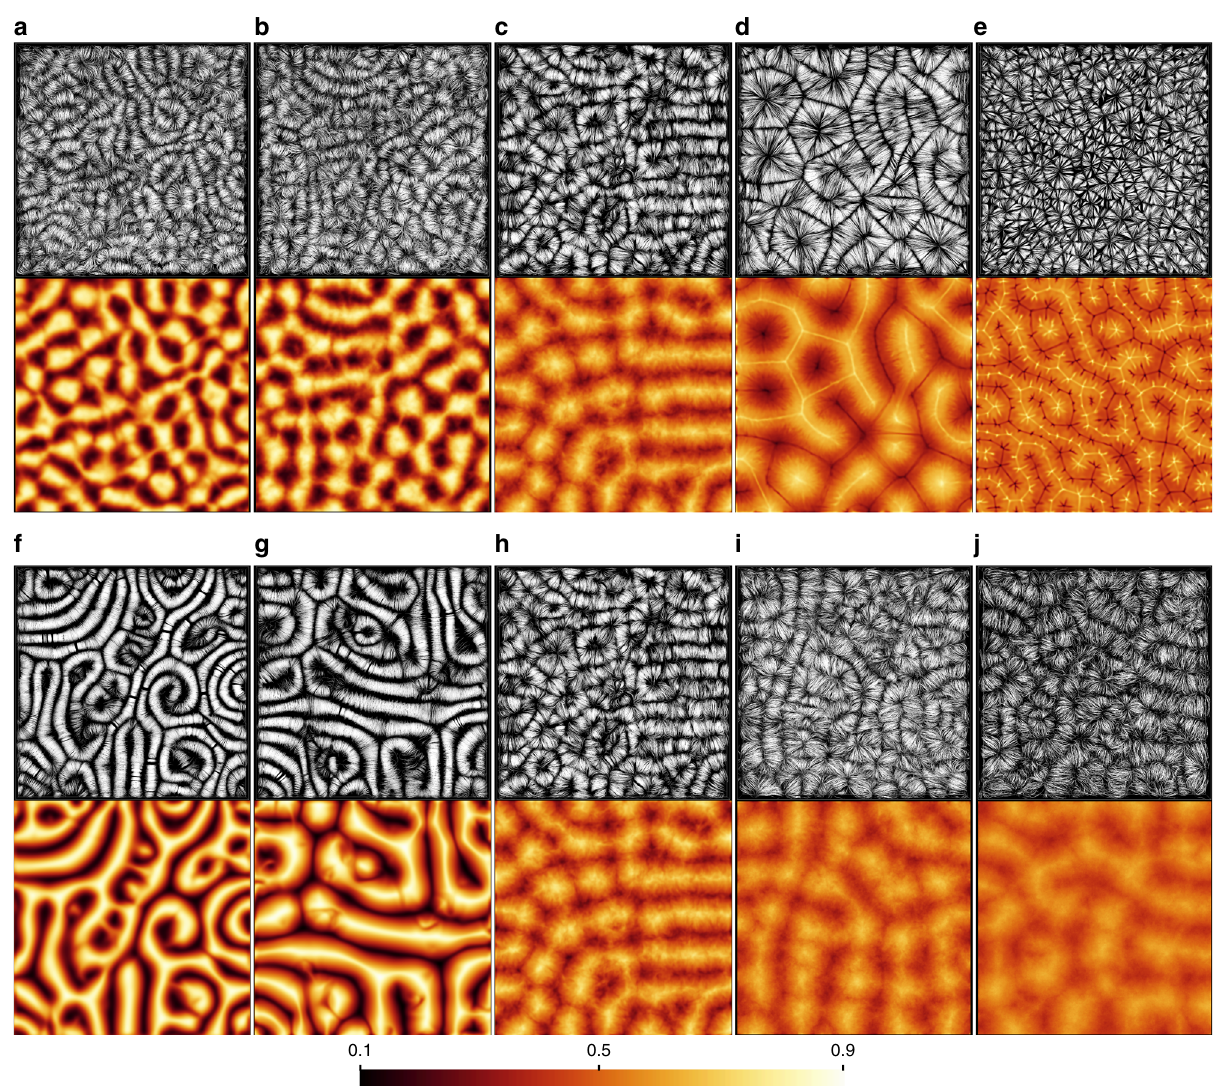
Fig. 3 Turbulent superstructures at different Rayleigh and Prandtl numbers. For each of the simulations fi eld line plots of the time-averaged velocity (top rows) and the corresponding time-averaged temperature in the midplane (bottom rows) are displayed. Turbulent Rayleigh-Bénard convection at a Rayleigh number of Ra = 10 5 ( a ) at Pr = 0.005, ( b ) at Pr = 0.021 (see also Fig. 1b, d), ( c ) at Pr = 0.7, ( d ) at Pr = 7, and ( e ) at Pr = 70. Averaging times in a – e are 21 free-fall times ( T f ) for Pr = 0.005, 27 T f for Pr = 0.021, 57 T f for Pr = 0.7, 207 T f for Pr = 7, and 375 T f for Pr = 70. Turbulent Rayleigh-Bénard convection at a Prandtl number of Pr = 0.7 at ( f ) Ra = 5 × 10 3 , ( g ) at Ra = 10 4 , ( h ) at Ra = 10 5 (same panels as in c ), ( i ) at Ra = 10 6 , and ( j ) at Ra = 10 7 . The averaging times are now 54 T f for Ra = 5 × 10 3 , 72 T f for Ra = 10 4 , 57 T f for Ra = 10 5 , 66 T f for Ra = 10 6 , and 72 T f for Ra = 10 7 . All shown cross sections are 25 H × 25 H with H being the height of the convection